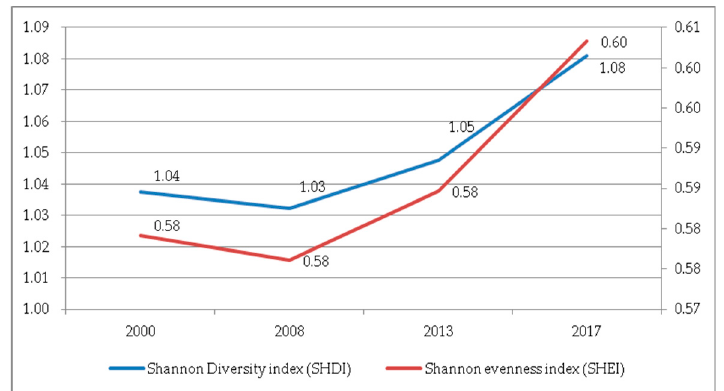
Figure 14. The Contagion Index (CONTAG) and IJI at the landscape level.